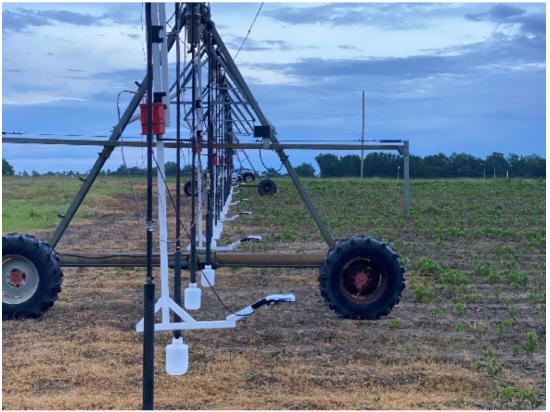
Figure 6. GreenSeekers and nodes mounted on brackets along the length of the lateral move fertiga- tion